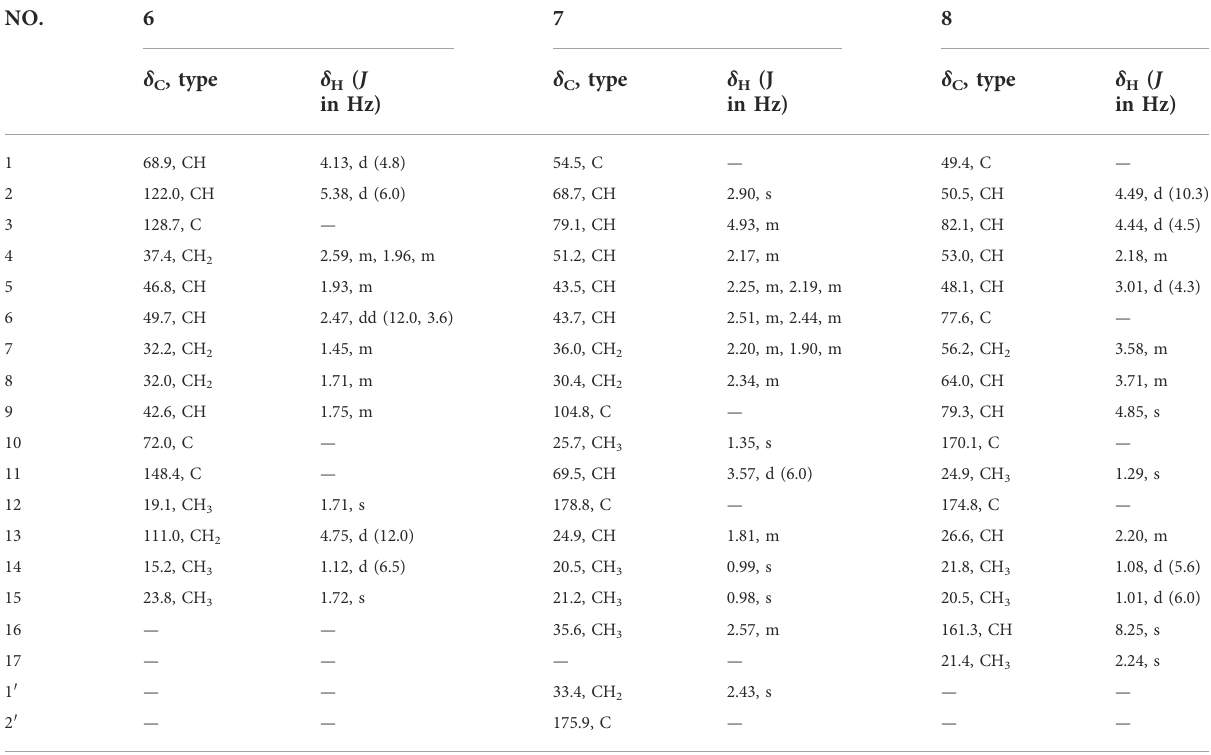
TABLE 2 1 H and 13 C NMR (600 MHz) data for 6-8 in CDCl 3 .